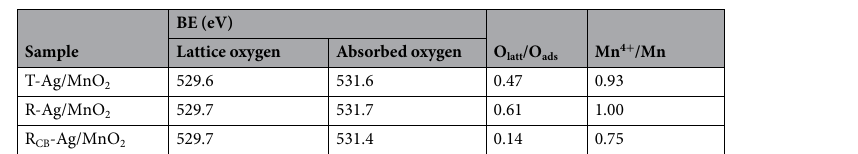
Table 3. Contents of different oxygen species and